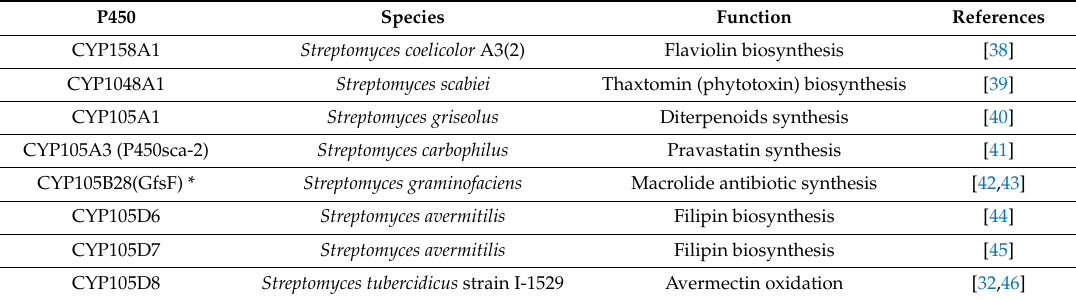
Table 4. List of Streptomyces species P450s involved in synthesis of secondary metabolites. P450